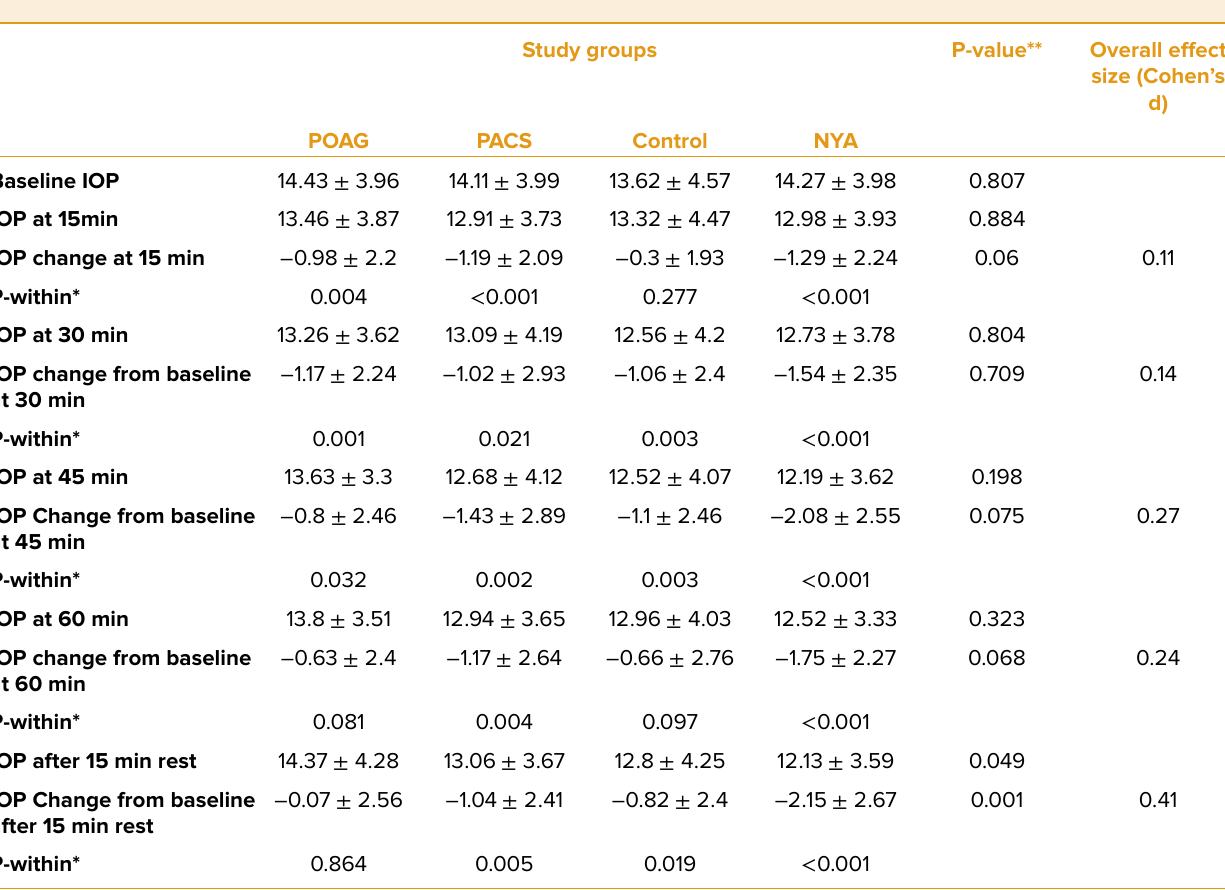
Table 2. Changes in IOP between and within study groups throughout the